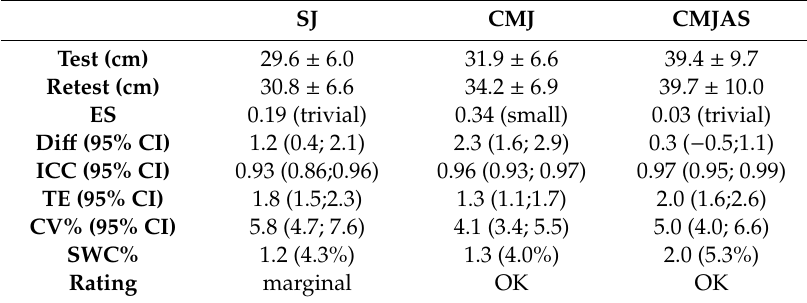
Table 2. Test-retest reliability and usefulness of My Jump 2 in male recreationally active